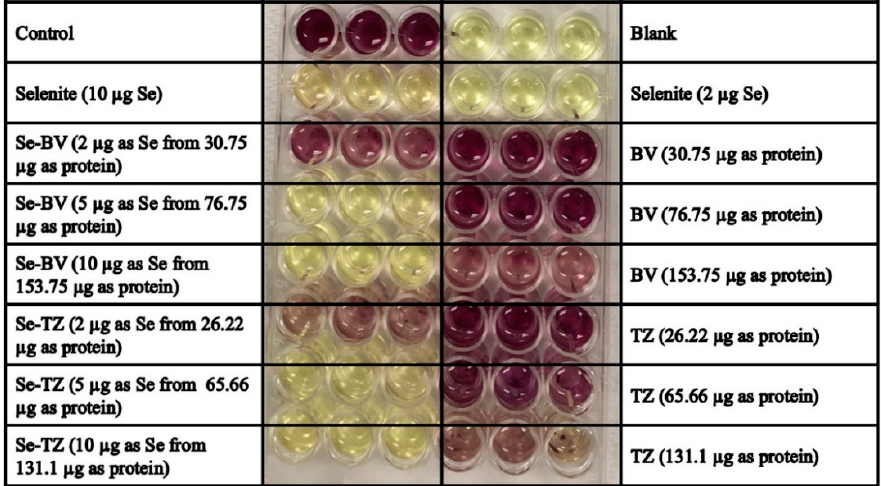
Figure A3. HME50-5E MTT Plate Photo on Day 5 Post Treatment showing the insoluble formazan salt.